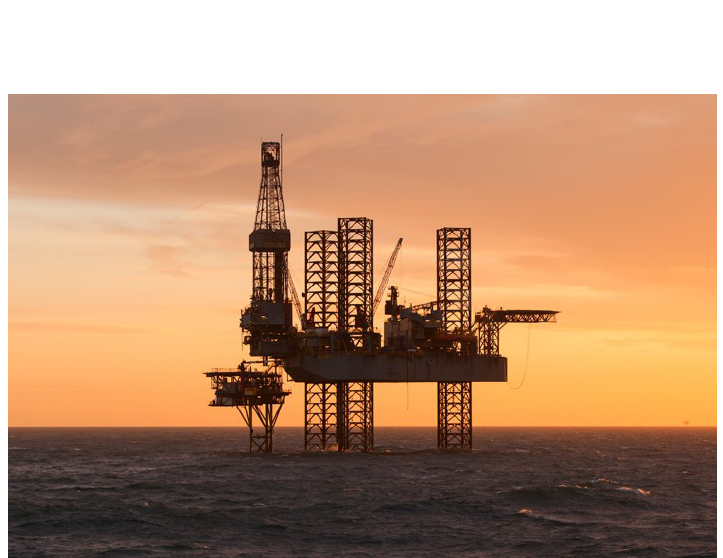
Fig. 7. – Offshore drilling